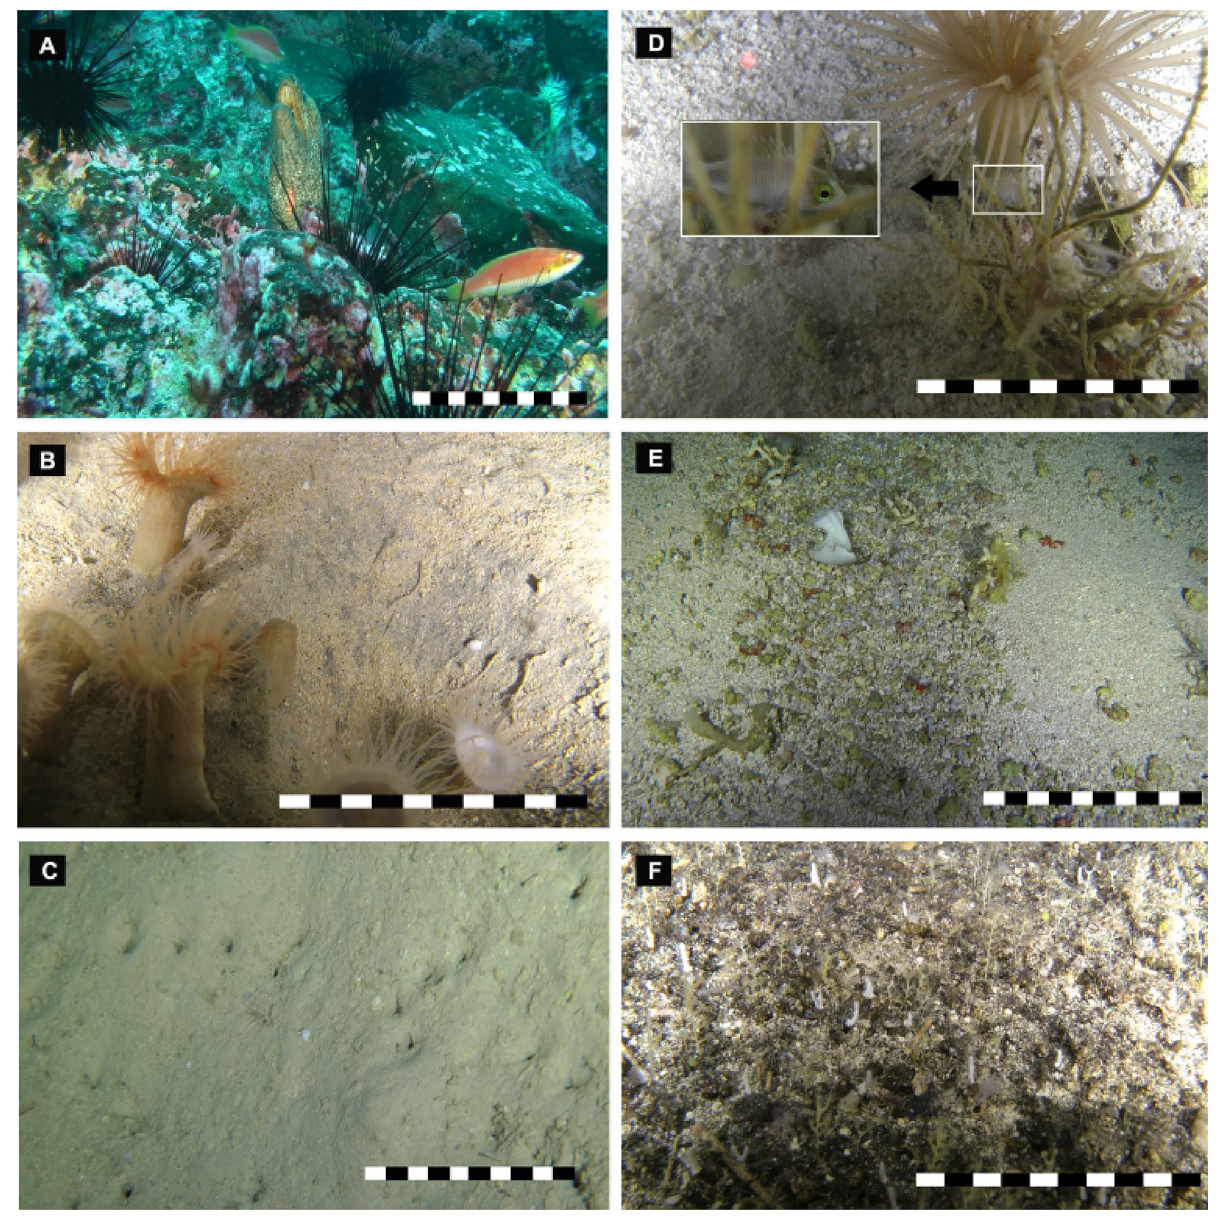
Figure 3. Benthic microhabitats on the upper slope of Desventuradas islands ( A – C ) and summits of seamounts ( D – F ) at the Nazca-Desventuradas Marine Park. ( A ) Rocky bottom dominated by incrusting red algae, sea urchin Centrostephanus sylviae , the cracks and faults of the rocky bottom, are used as habitats for moray eels ( Gymnothorax porphyreus ) and small fishes ( Pseudolabrus cf. gayi ), ( B ) coarse sand flat bottom dominated by anemones ( Hormathia sp.), ( C ) soft-sediment with burrows and excavations, ( D ) microhabitats of cerianthid anemones and hydrozoan colonies, ( E ) unattached nodules of crustose coralline red algae (Rhodoliths), demosponges, and coquina of pteropod shells, ( F ) irregular rock bottom with structures fractured, faulted and folded, characterized by sea pens ( Scleroptilum sp.) and hydrozoan corals ( Stylaster s p.). Scale bar: 10 cm. Image credits: